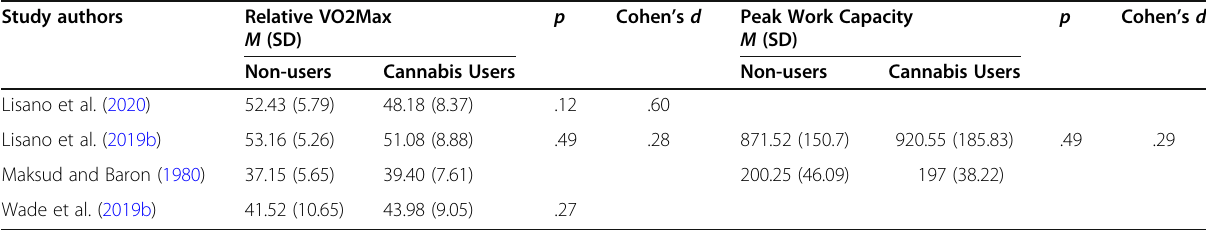
Table 1 Fitness measures used in studies